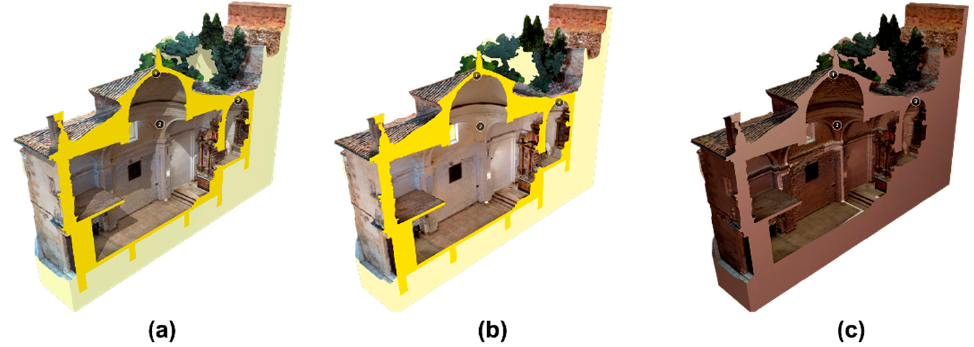
Figure 13. ( a ) PBR with lit shading, ( b ) shadeless PBR and ( c ) MatCap renderer.